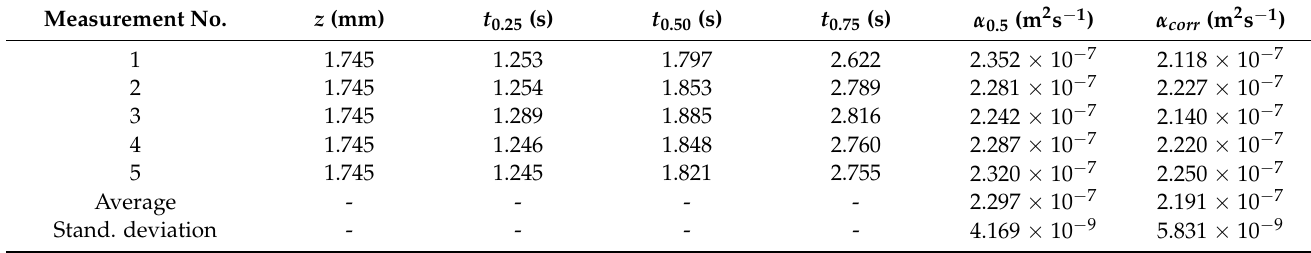
Table 2. Thermal